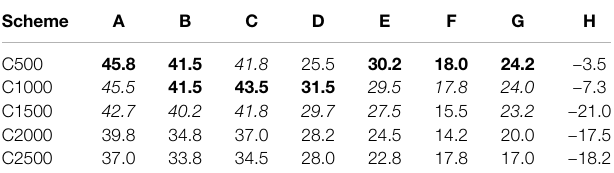
TABLE 4 | RATE (%) of the simulated surface meteorological fi elds under different cutoff wavelengths with nudging all variables in summer 2009 (bold type indicates the optimal RATE in a given subregion, and italic values indicate the schemes with RATE values greater than 90% of the optimal RATE).